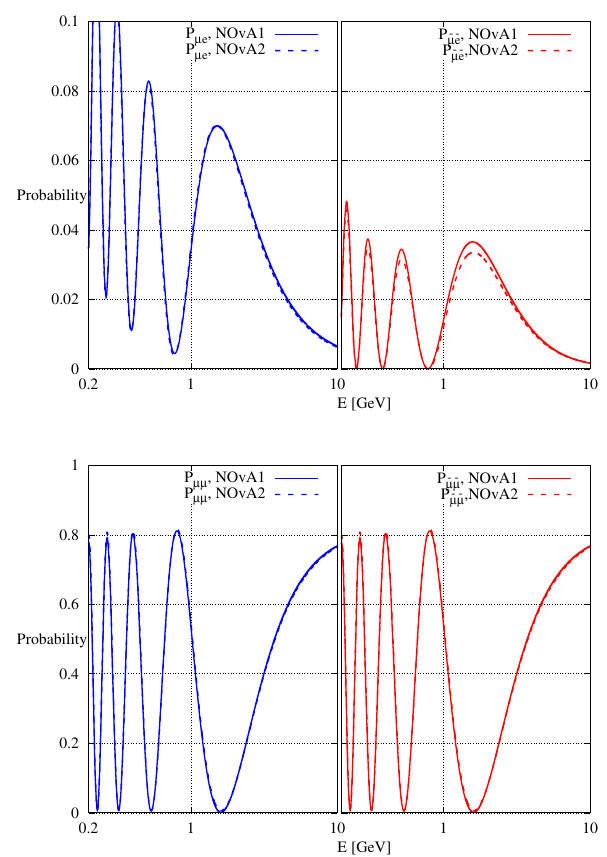
Fig. 9 Comparison of probabilities for NO ν A with NH and different sets of values for α 20 , α 21 and α 22 . For NOvA1 (NOvA2), α 00 = 0 . 93; α = 0 . 95; | α = 3 . 6 × 10 − 2 | ; α = 1 . 3 × 10 − 1 (0); α = 11 10 20 21 2 . 1 × 10 − 2 (0); α 22 = 0 . 61 (1). The standard oscillation parameters are fixedattheirNHbest-fitvalues,takenfromRef.[57,61].Theleft(right) panel shows the probabilities for neutrino (anti-neutrino) channel and the upper (lower) panel shows probabilities for appearance (disappear- ance)